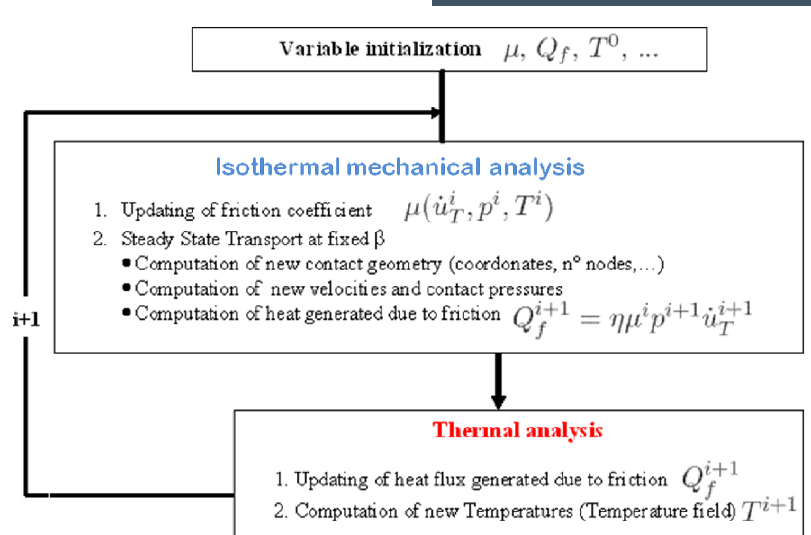
Figure 15. Steady State Thermal algorithm.